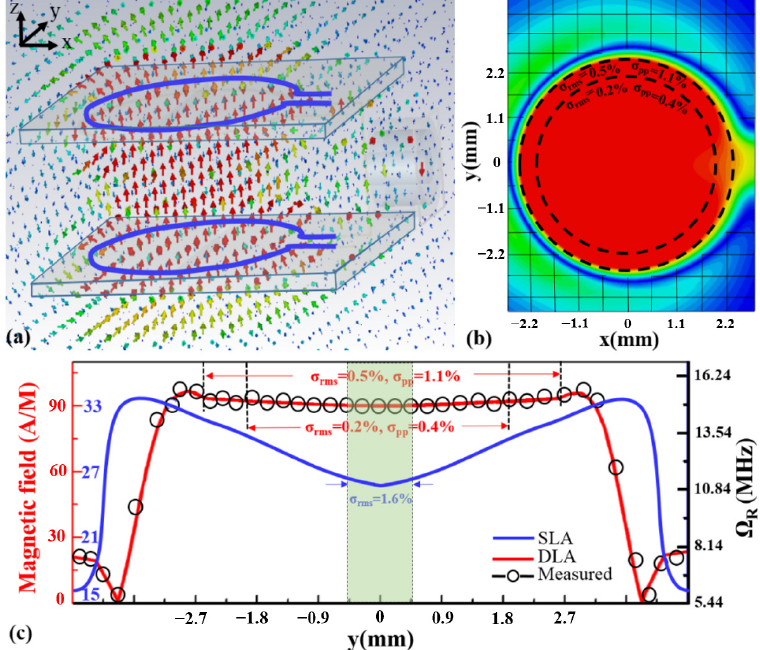
Figure 1. Construction and measurement of the homogeneous microwave field. ( a ) Homogeneous microwave field produced between the two parallel Ω –shaped microwave antenna structures. ( b ) Simulation of the field distribution. ( c ) The magnetic field in a different area.